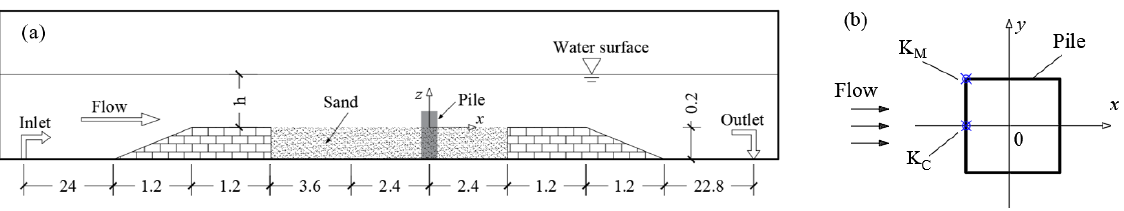
Figure 1. Test flume and coordinate system modified from Du and Liang [24], unit: m, ( a ) Side view of the flume, ( b ) Sketch view of K M and K C points.